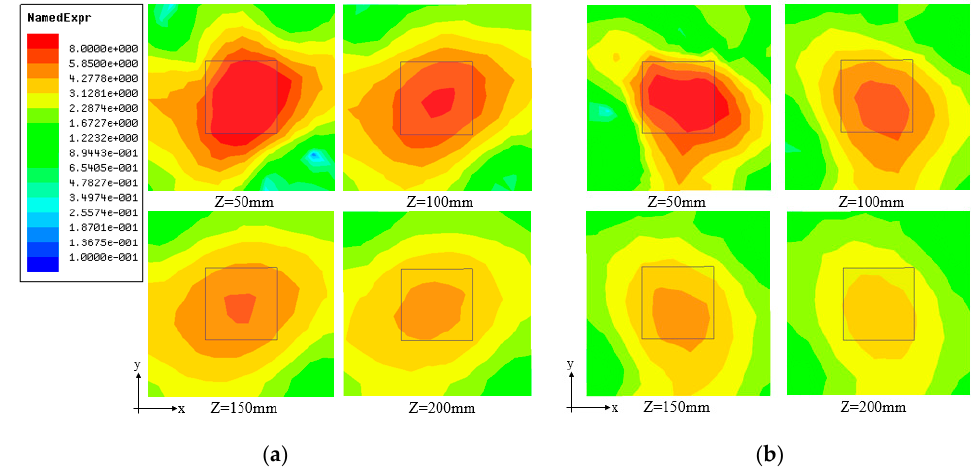
Figure 13. Distribution of simulated electric field components (Ex, Ey) at different heights with six spiral loops: ( a ) Ex distribution and ( b ) Ey distribution.